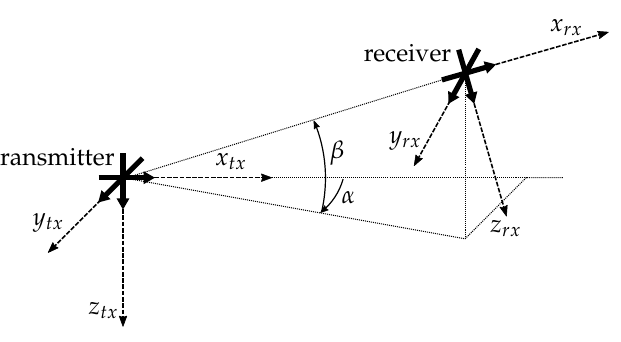
Figure 7. Transmitter–receiver arrangement expanded by the angles α and β [15].